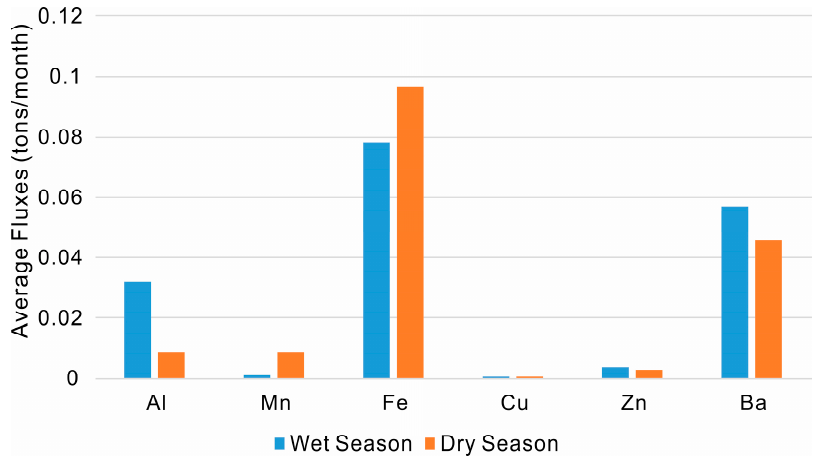
Figure 7. Estimated fluxes of dissolved heavy metals to the Mekong River.